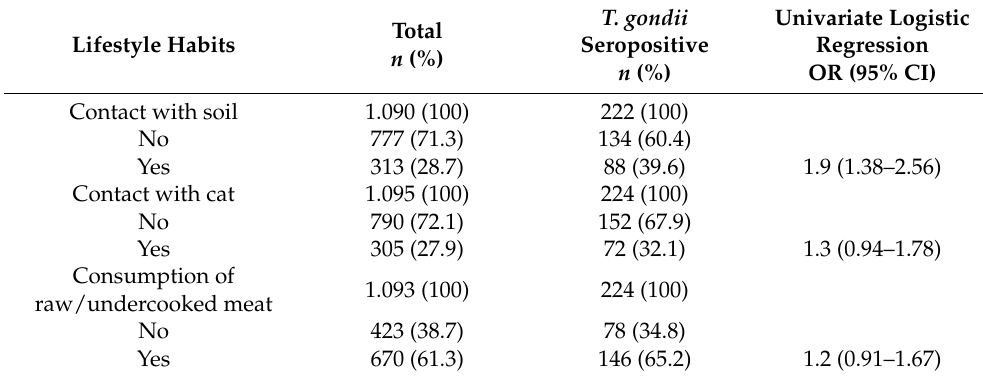
Table 2. Lifestyle habits of participants and univariate logistic regression for T. gondii infection.